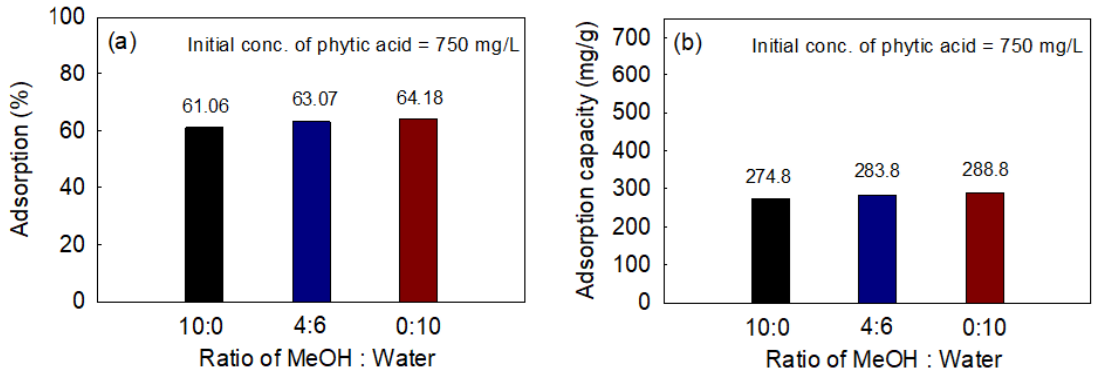
Figure 10. Phytic acid adsorption results: ( a ) phytic acid adsorption percentage and ( b ) phytic acid adsorption capacity.